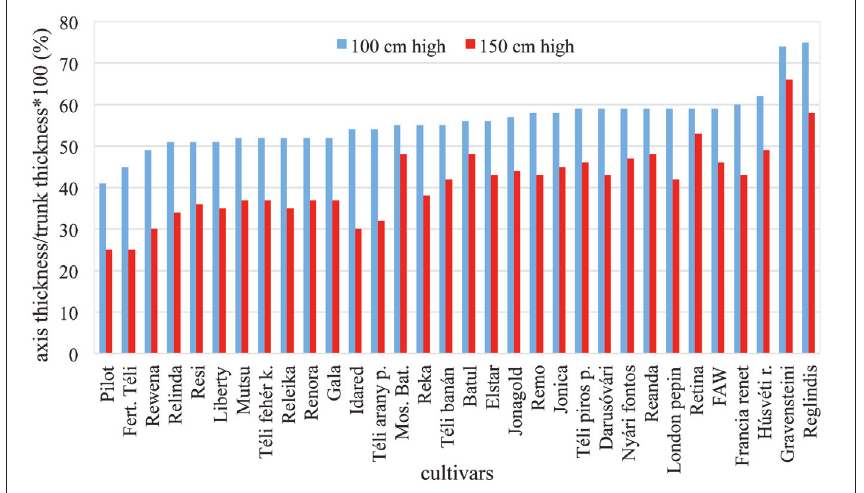
Figure 1. Ratio of the central axis and trunk thickness of 14 years old apple trees in integrated production system (Debrecen – Pallag,